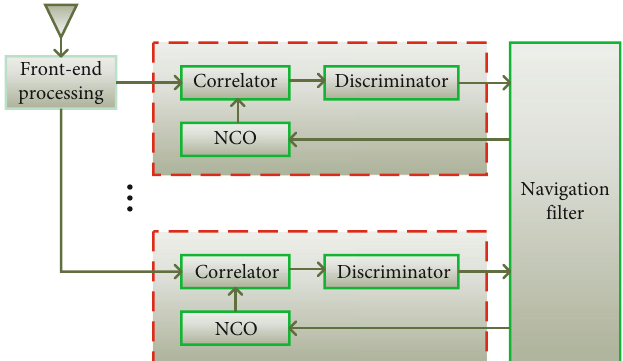
Figure 3: Basic architecture of the VTL.